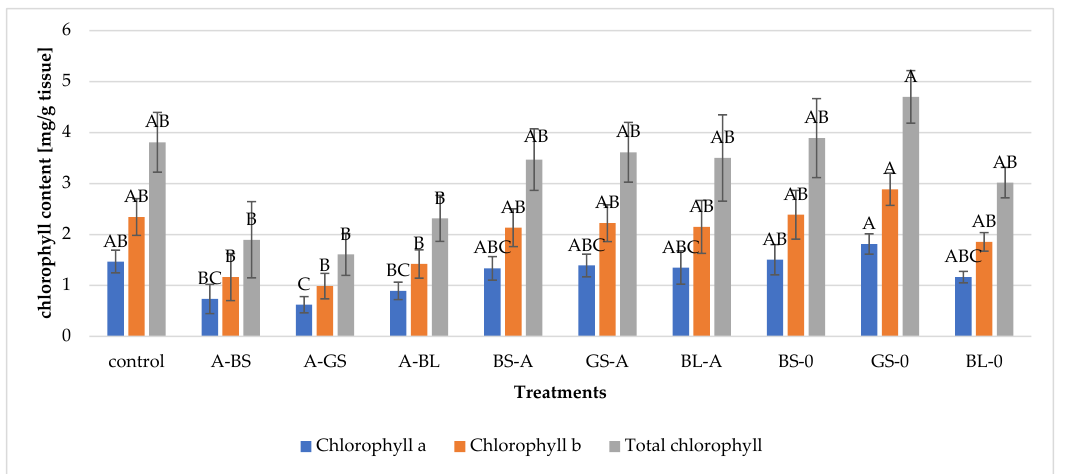
Figure 6. Results of biosurfactant treatments and fungal infections on the chlorophyll content comparing mean significance with Tukey HSD of bean’s leaves: BS-A: pre-treatment with B. subtilis before A. alternata infection; GS-A: pre-treatment with B.subtilis before A. alternata infection; and BL-A: pre-treatment with B. licheniformis before A.alternata infection; A-BS, A-GS, and A-BL: pre-treatments with supernatant of B. subtilis , G. stearothermophilus, and B. licheniformis supernatant; uninfected but B. subtilis , G. stearothermophilus and B. licheniformis treated plants. Capital letters indicate the statistically different results